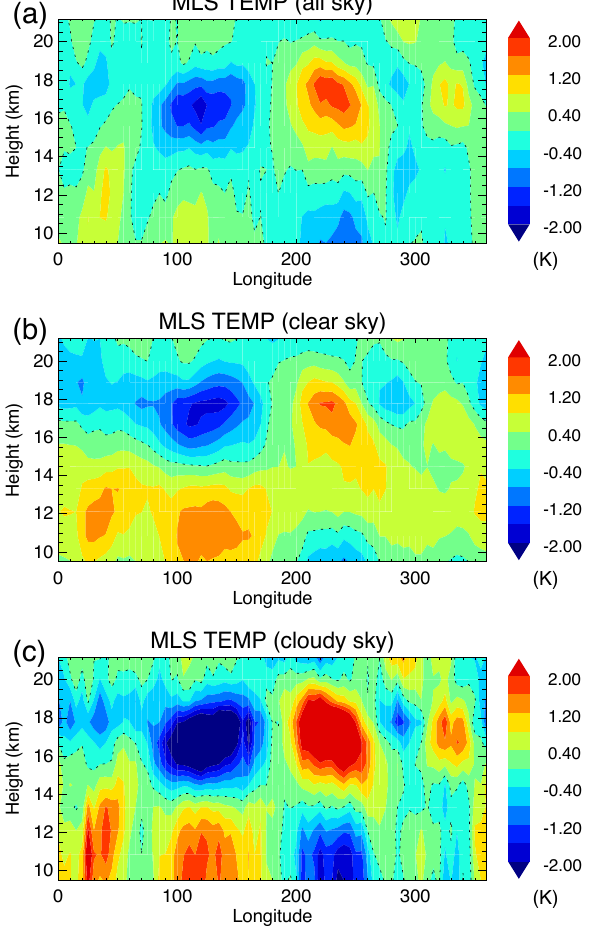
Fig. 2. Time mean zonal and vertical temperature anomalies from the zonal mean with removal of the annual cycle at each altitude (15°S - 15°N).